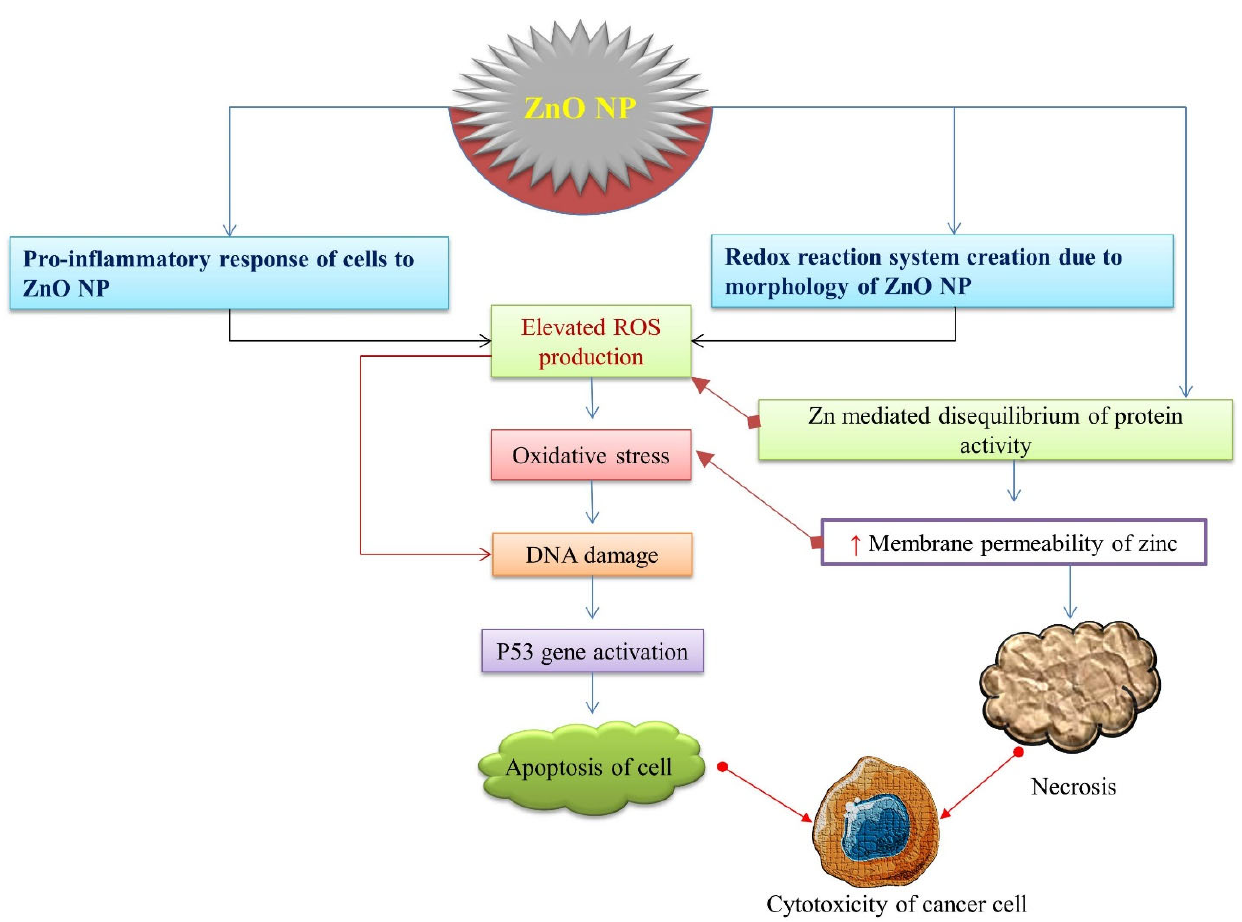
Figure 3. A schematic representation of cytotoxicity potency of ZnO-NPs leading to the death of cancer cells. ZnO-NPs induce ROS production sequentially, leading to oxidative stress, DNA damage, p53 activation, and apoptosis of cancerous cells.